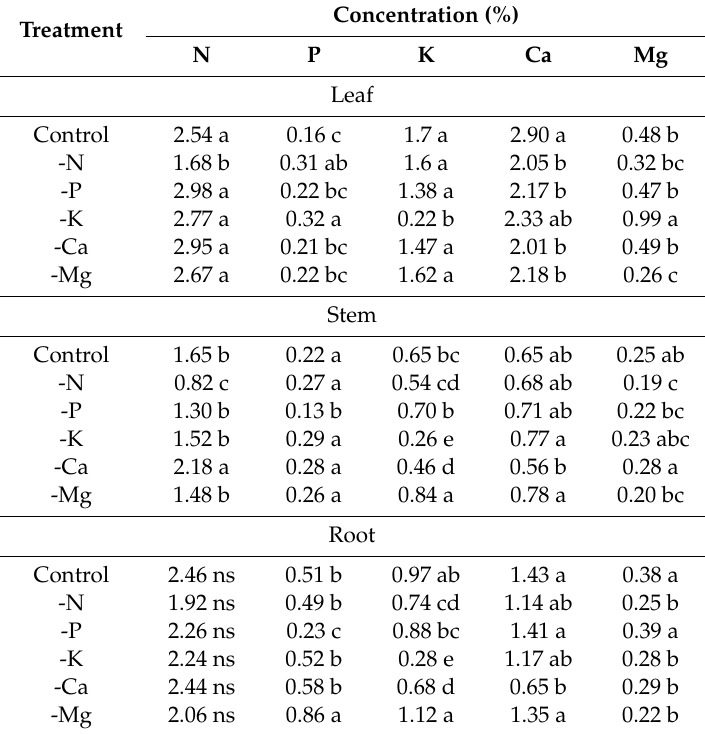
Table 3. Content of N, P, K, Ca, and Mg in leaf, stem a root of fig tree plants with macronutrient deficiency.